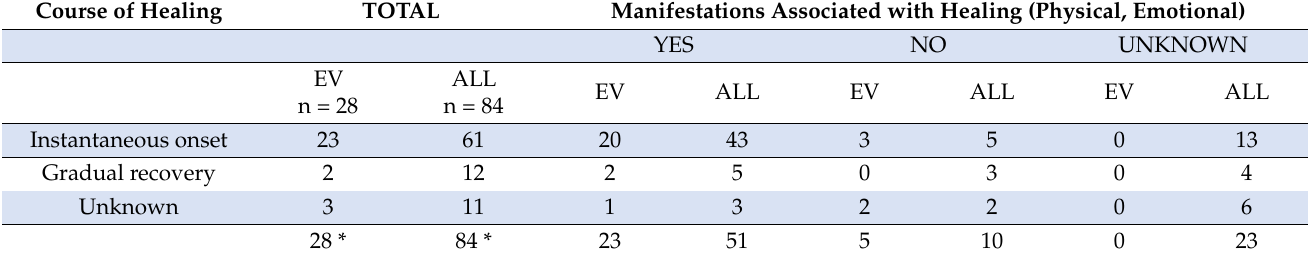
Table 11. Course of healing and associated manifestations for the subgroup of evaluated healings (EV) and for all reported healings (ALL).